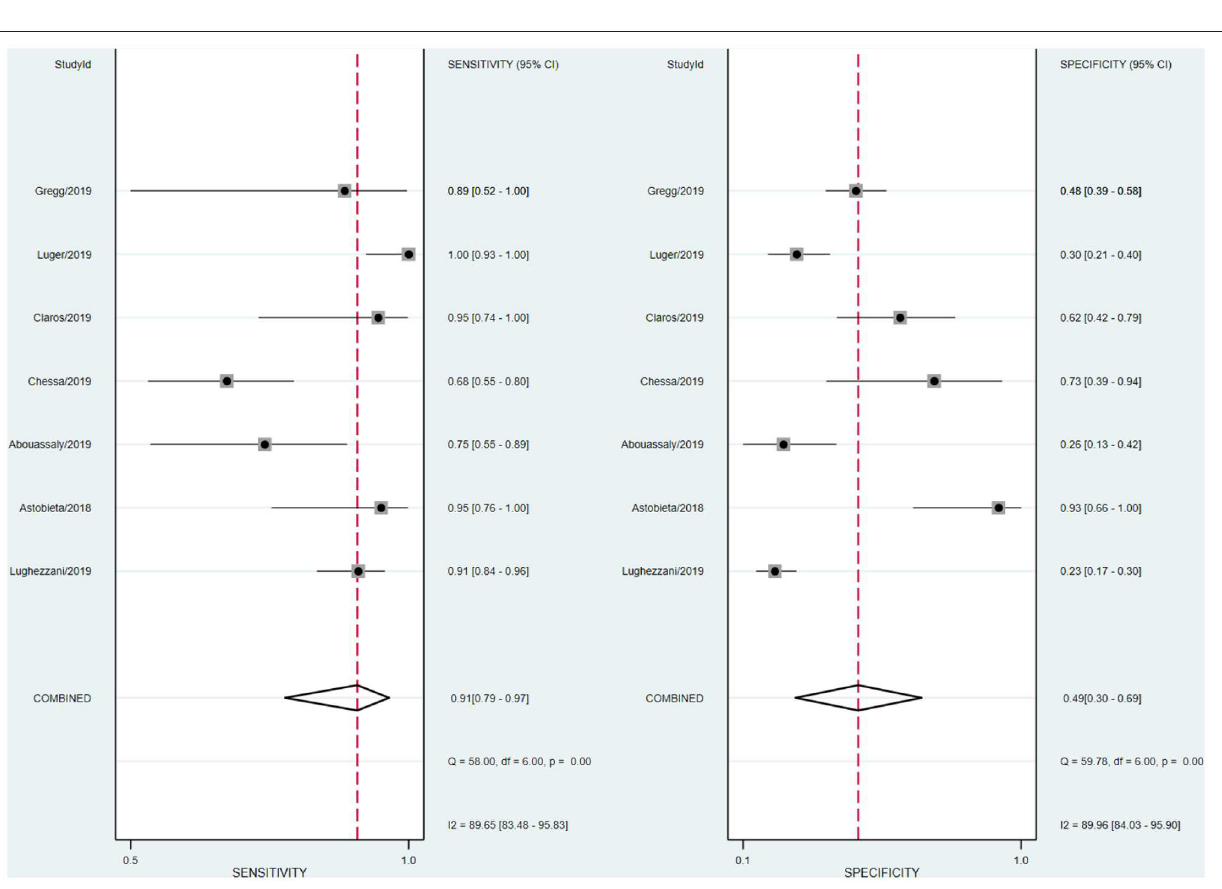
FIGURE 4 | Forest plots of sensitivity and specificity of